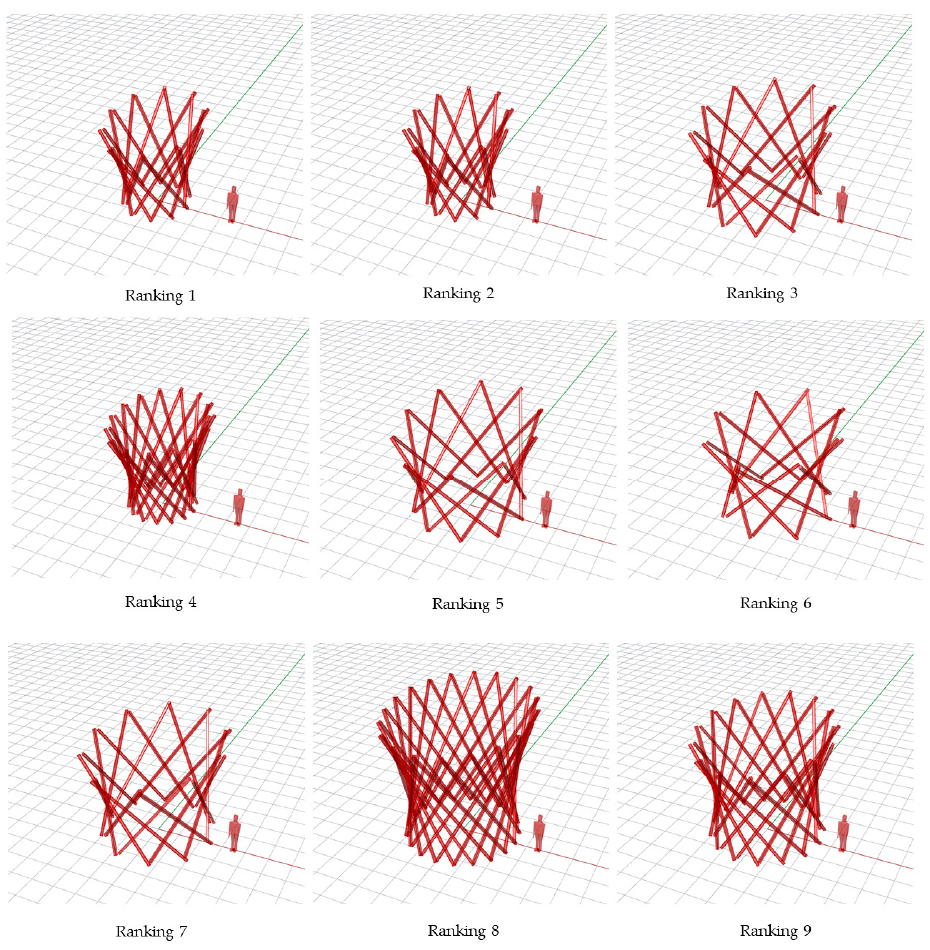
Figure 12. Nine best design solution based on fitness function calculation .